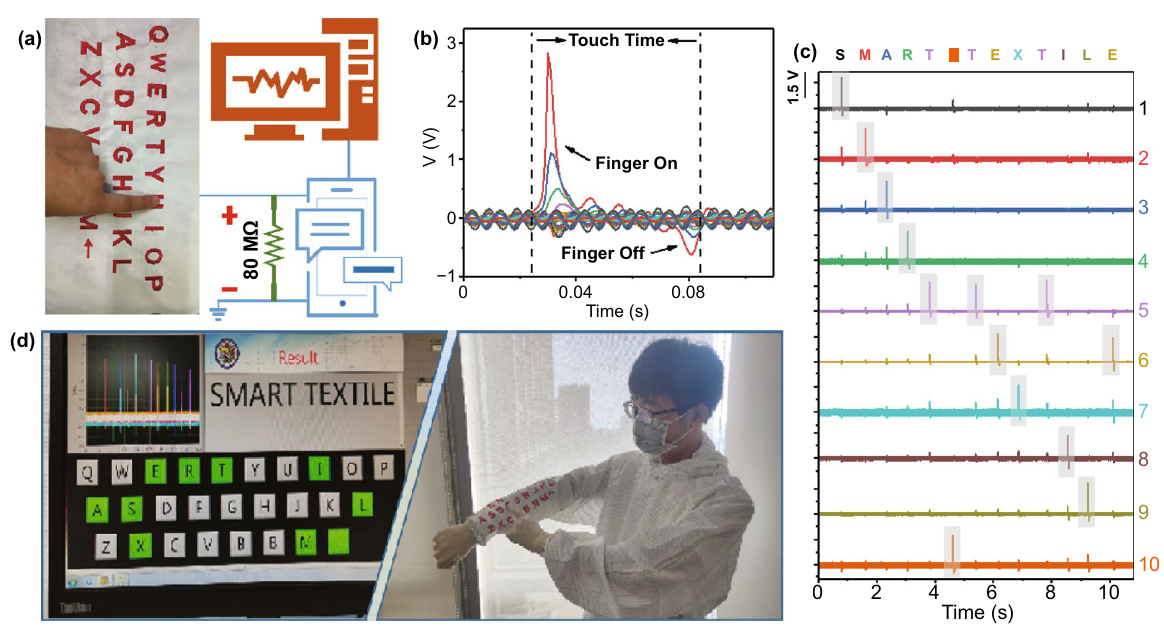
Fig. 5 Working principle of the self-powered wearable keyboard as a biometric self-recognition system. a Schematic diagram of a SPWK work- ing with a terminal device. b A diagram of a voltage signal when a finger strikes a single keypad. c Signal output waveform by continuously typing the string of "SMART TEXTILE" that is recorded in real time without uncomfortable delay. d Photograph showing the SPWK system for the real-time keystroke tracing and